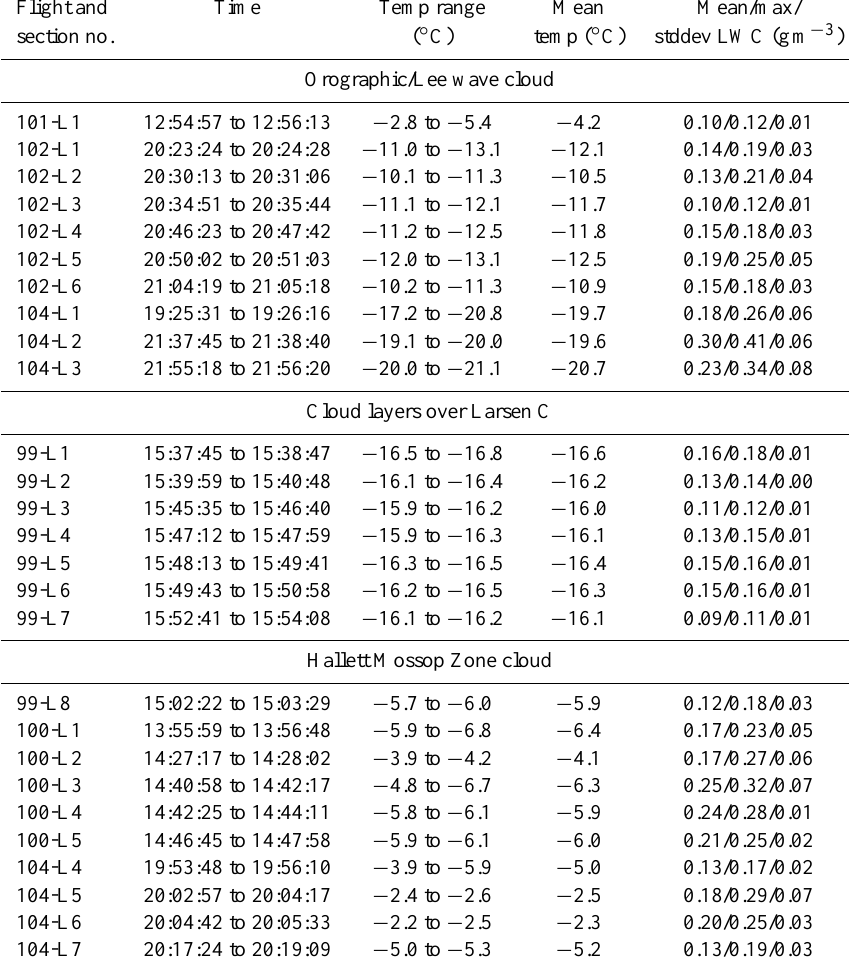
Table 2. Details on periods when liquid water, but no ice were observed. Flight and Time Temp range Mean Mean/max/ section no. ( ◦ C) temp ( ◦ C) stddev LWC (gm − 3 ) Orographic/Lee wave